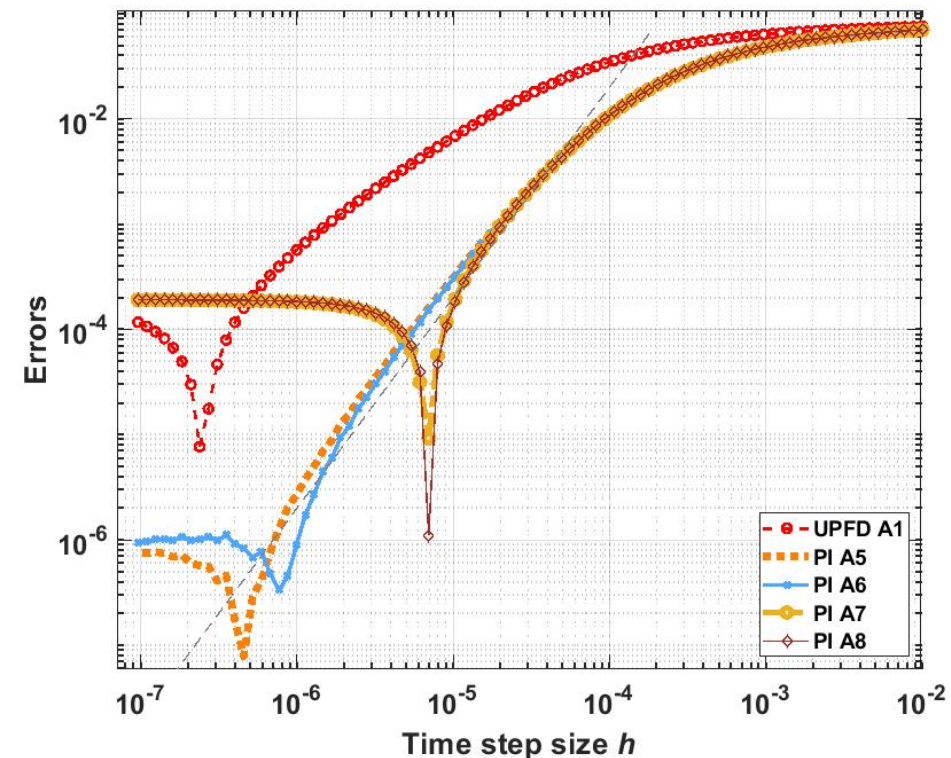
Figure 7. The L ∞ errors as a function of time step size h for the numerical solutions of Equation (1) in